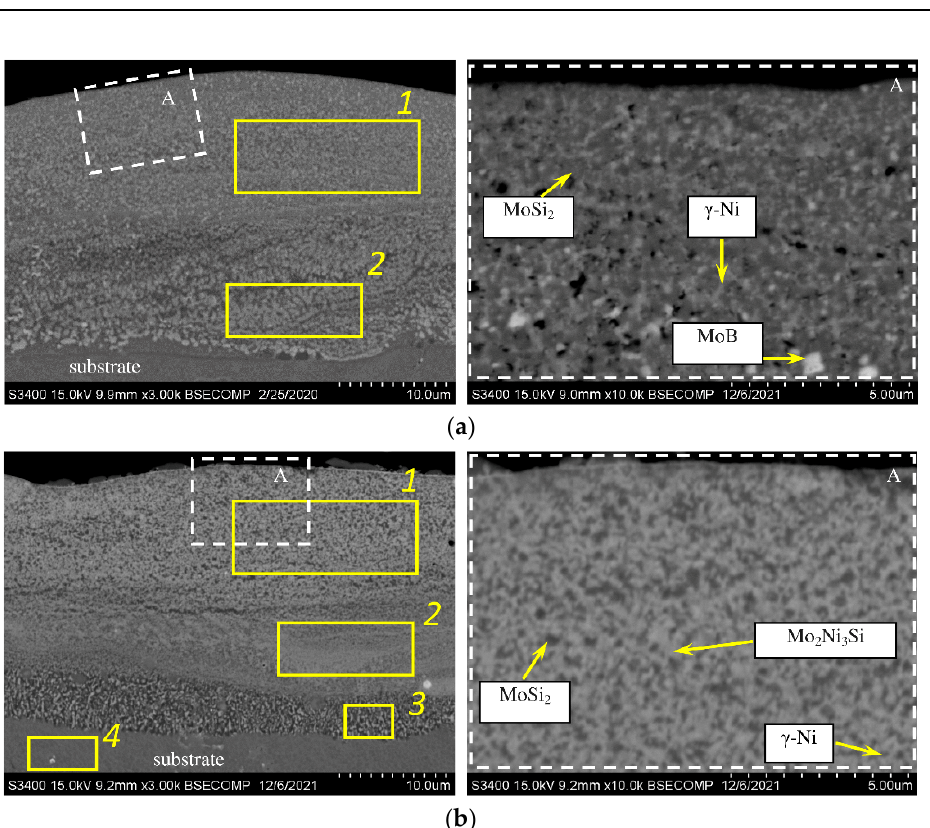
Figure 2. Microstructure of the coating deposited using the MoSi 2 –MoB–HfB 2 electrode: in the as-deposited state ( a ) and after vacuum annealing ( b ).